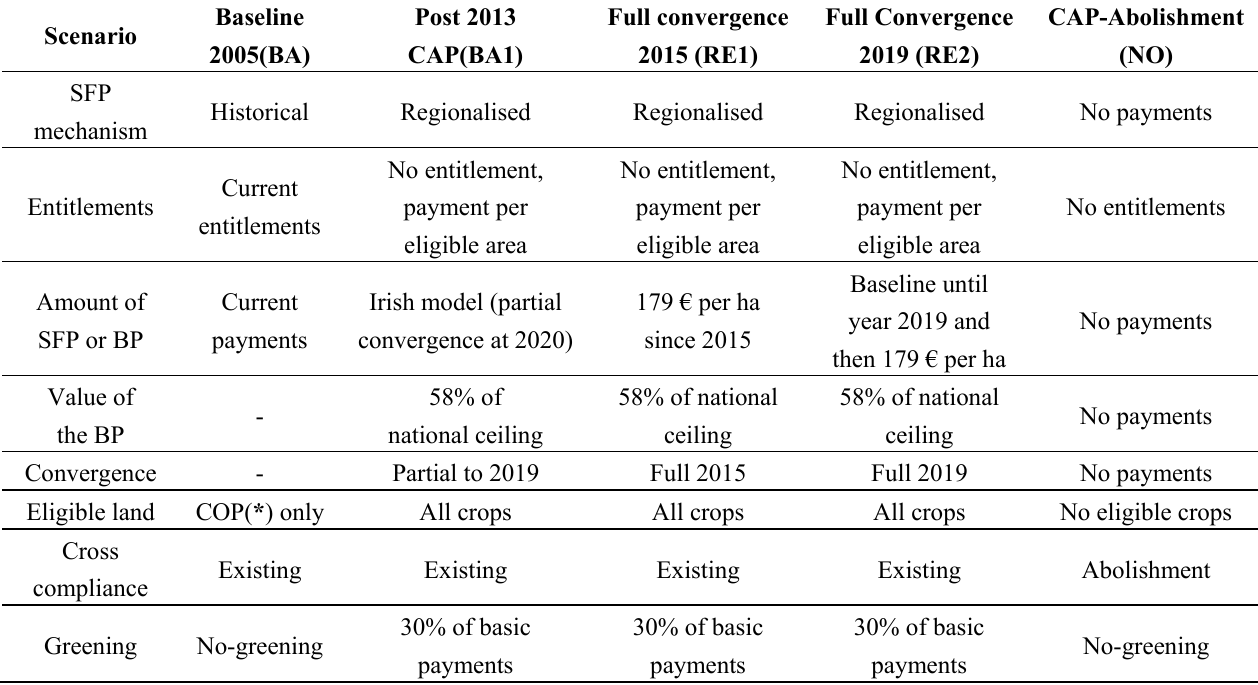
Table 3. Policy parameters for each